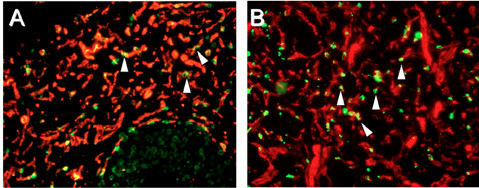
Cell proliferation. PECAM (red) and BrdU (green). A) DMSO control treated B) Compound E, (20 × magnification). Please note that proliferation was not blocked by compound E (B) and even might be increased over control.